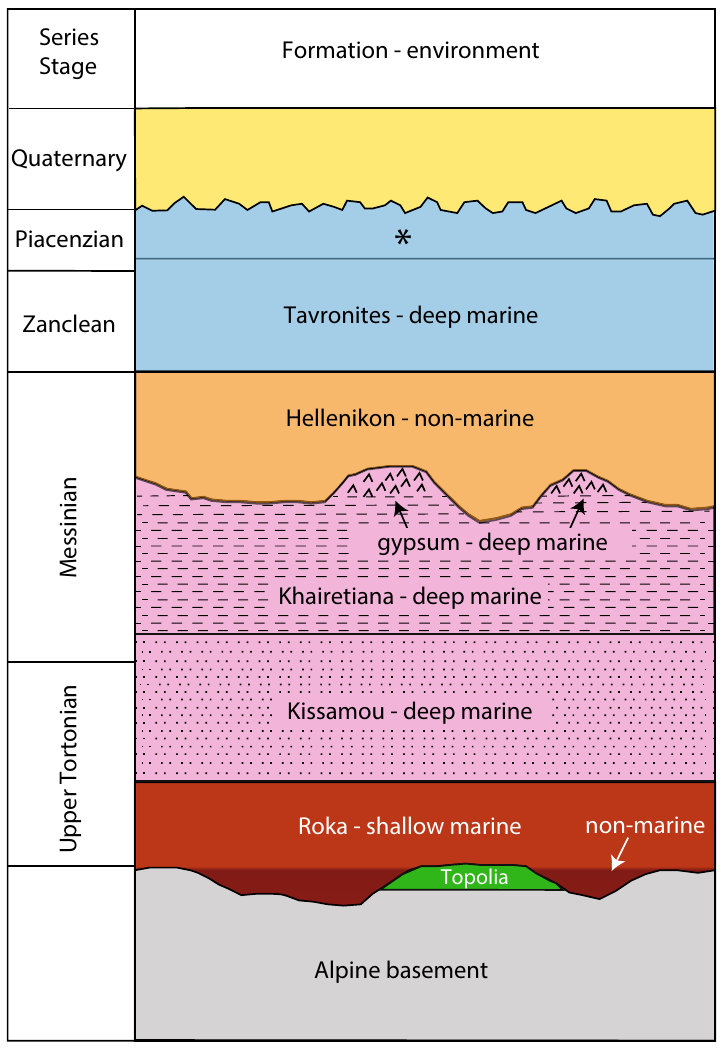
Figure 2. Lithostratigraphy of the Neogene in the area west of Chania after Freudenthal 5 and Meulenkamp et al. 8 . The chronostratigraphic position and depositional environment of the lithostratigraphic units is based on Van Hinsbergen and Meulenkamp 9 and this study. Asterisk refers to the shallowing top of the Tavronitis Fm which is nowhere exposed except probably at